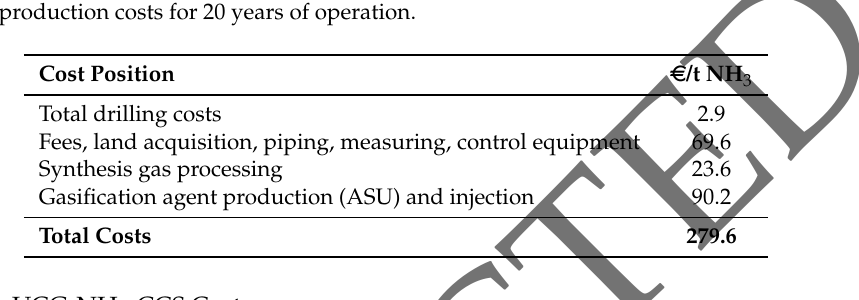
Table 15. Individual components of levelized onshore Underground Coal Gasification (UCG) based ammonia production costs for 20 years of operation.